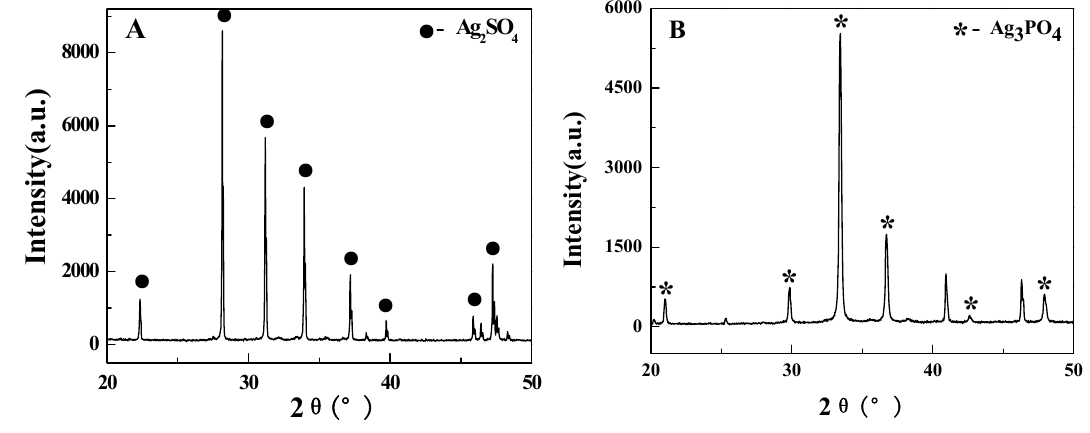
Figure 4. The X-ray diffraction spectra of the reaction residues [A: Ag(I)/S